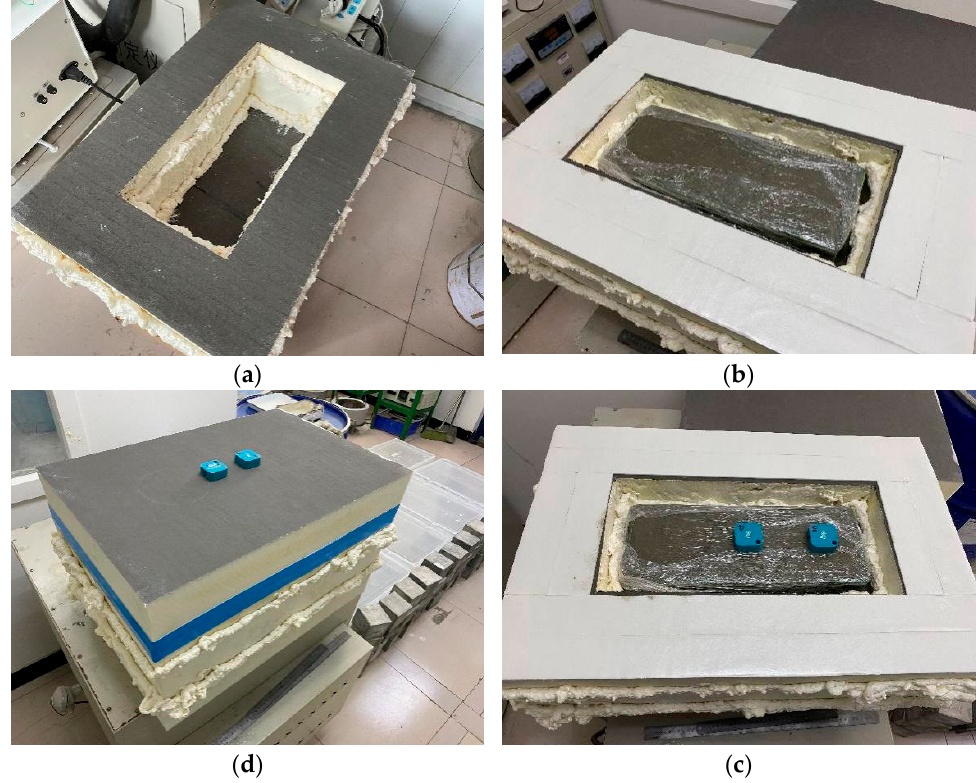
Figure 1. Processes of insulation curing of concrete. ( a ) Prepare insulation box; ( b ) Put specimen; ( c ) Place temperature sensor; ( d ) Glue the top board.